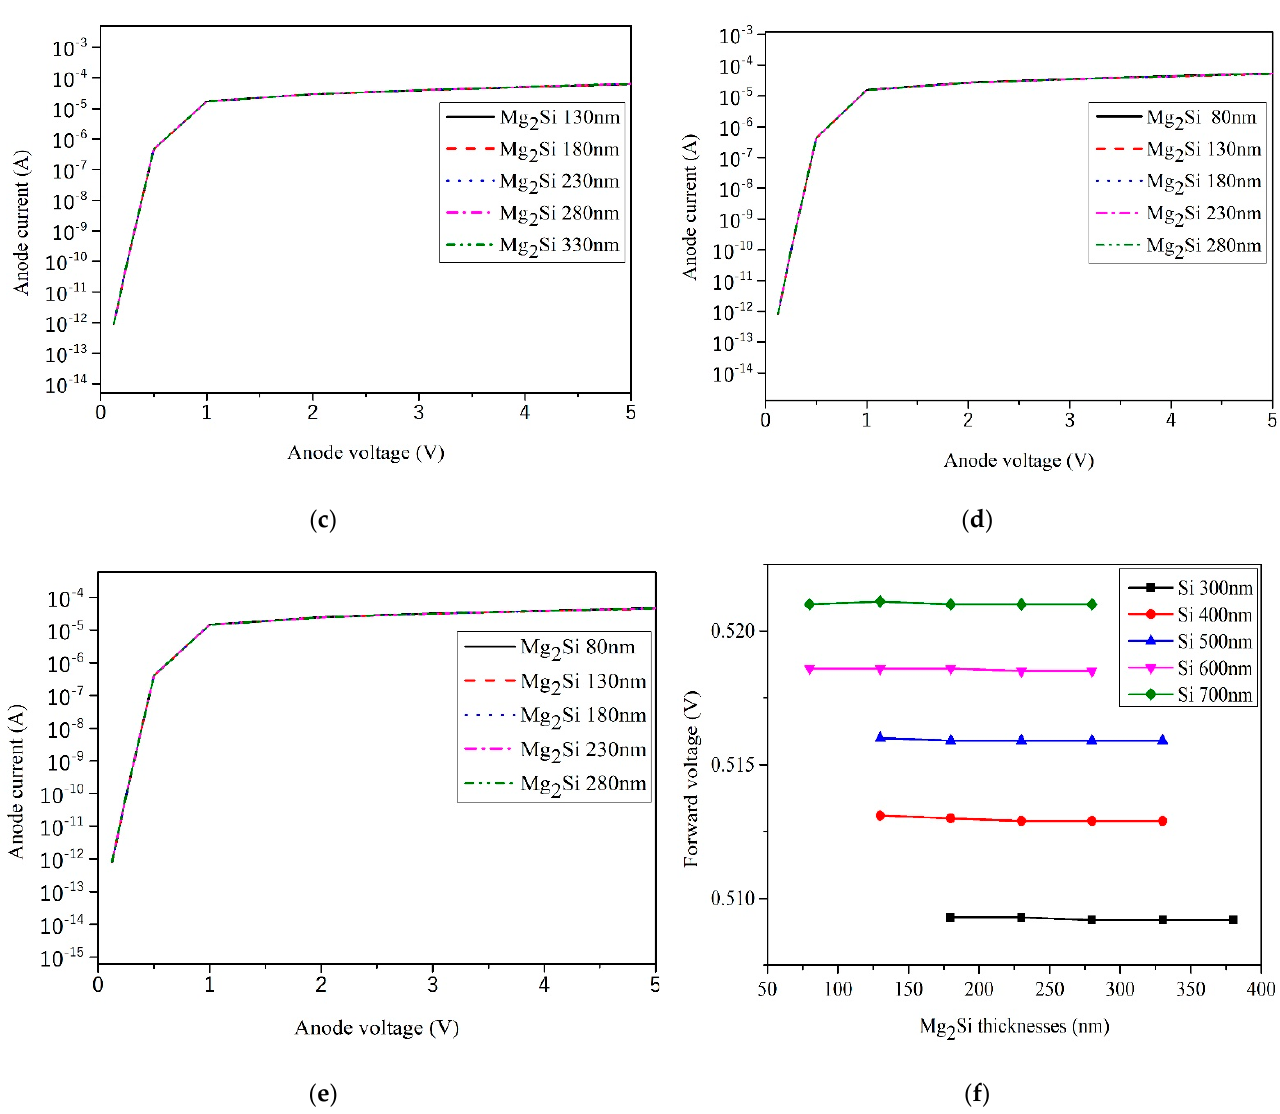
Figure 6. The forward I–V curves of the heterojunction PD with different Mg 2 Si thicknesses of 300 nm, 400 nm, 500 nm, 600 nm, and 700 nm Si thicknesses were plotted on a semilog scale. ( a ) Si-300 nm; ( b ) Si-400 nm; ( c ) Si-500 nm; ( d ) Si-600 nm; ( e ) Si-700 nm; ( f ) The effect of thicknesses on the forward voltage.